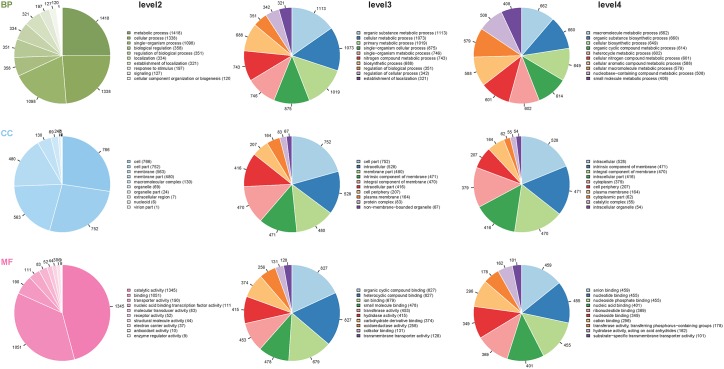
Distribution of the proteins classified into different GO terms at the second, third and fourth levels. The different colors in pies represent different GO terms. The area is the relative proportion of proteins in each GO term. The nine pie charts were sorted by the three main categories, BP, biological processes; CC, cellular components, and MF, molecular function from up to down and level of second, third and forth from left to right. The descriptions of BP, CC, and MF are more detailed with the increase of level numbers.